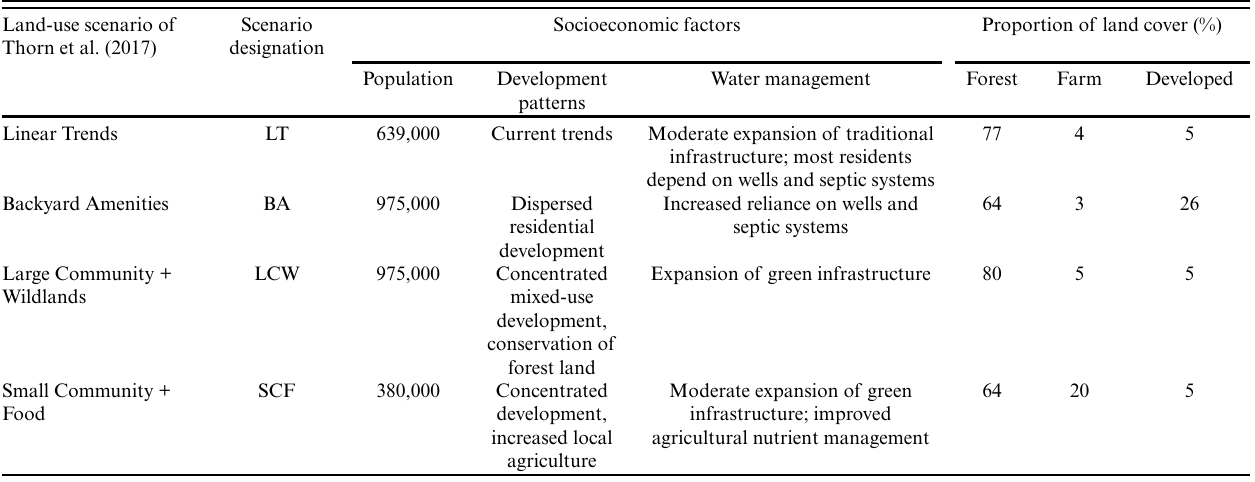
Table 2. Socioeconomic and land-cover scenarios